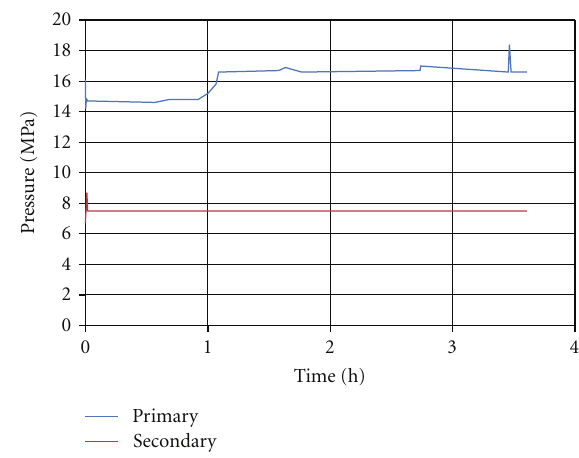
Figure 15: Pressures versus transient time for primary and secondary circuit